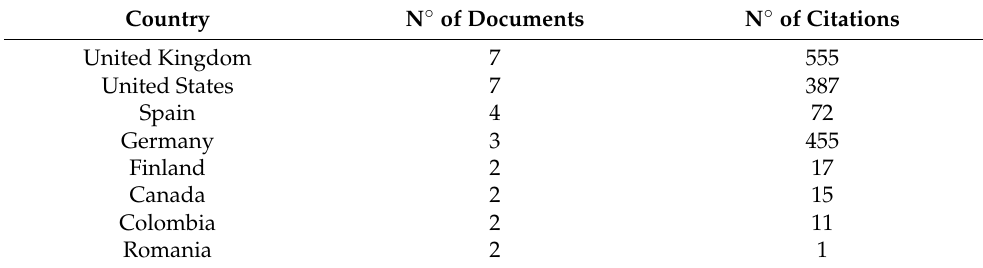
Table 2. Top eight countries per documents. Country N ◦ of Documents